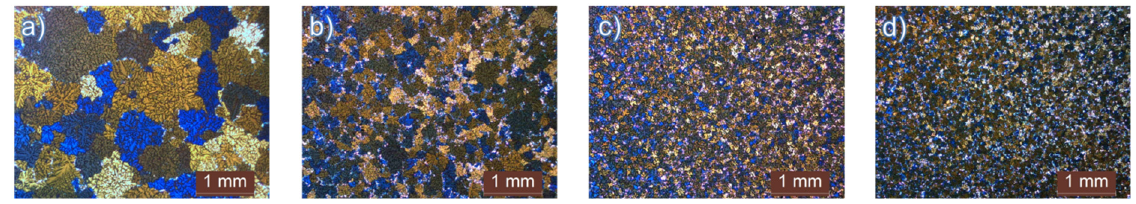
Figure 2. Influence of superheating on the grain size for ( a ) CP AZ91 (AGS: 332 μ m), ( b ) CP AZ91 SH (AGS: 169 μ m), ( c ) HP AZ91 (AGS: 98 μ m), and ( d ) HP AZ91 SH (AGS: 87 μ m).